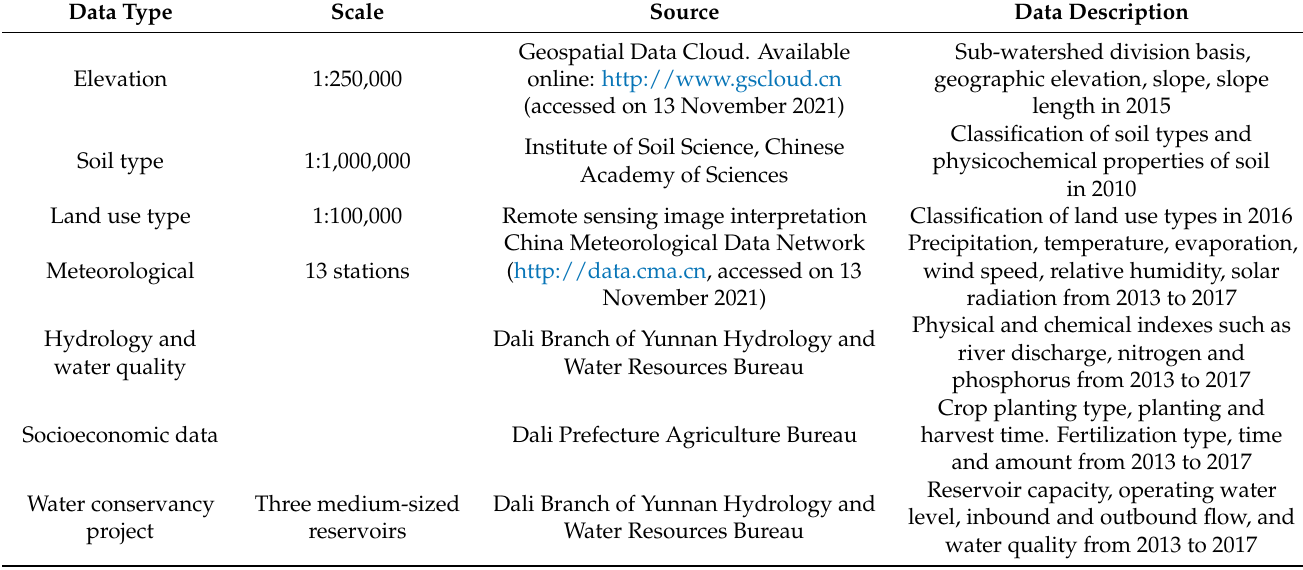
Table 1. Date type scale and data